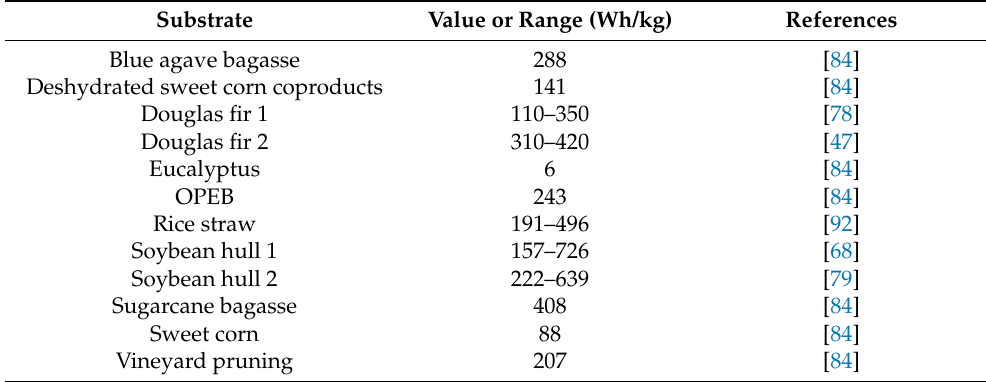
Table A1. Specific mechanical energy for some lignocellulosic biomass extrusion (Wh/kg).